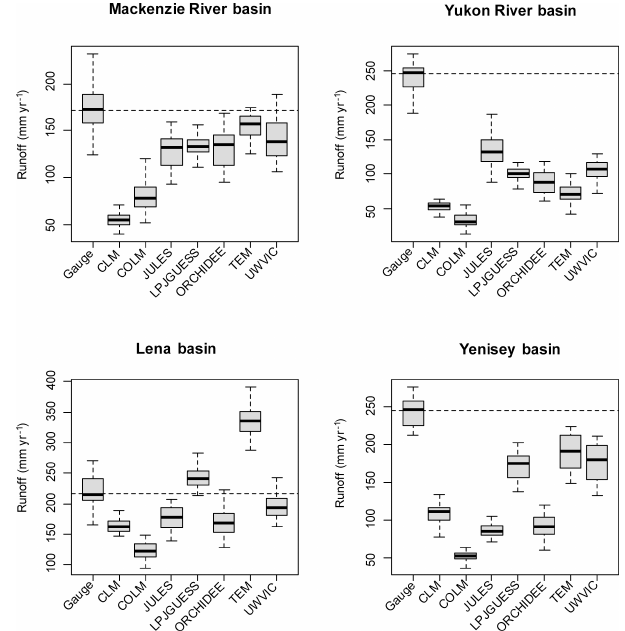
Figure 7. Discharge comparison between gauge station data and model output for each river basin. Dashed line indicates mean annual discharge at gauge station. Boxplots derived from mean annual-discharge (total runoff) simulations for the period of 1970 to